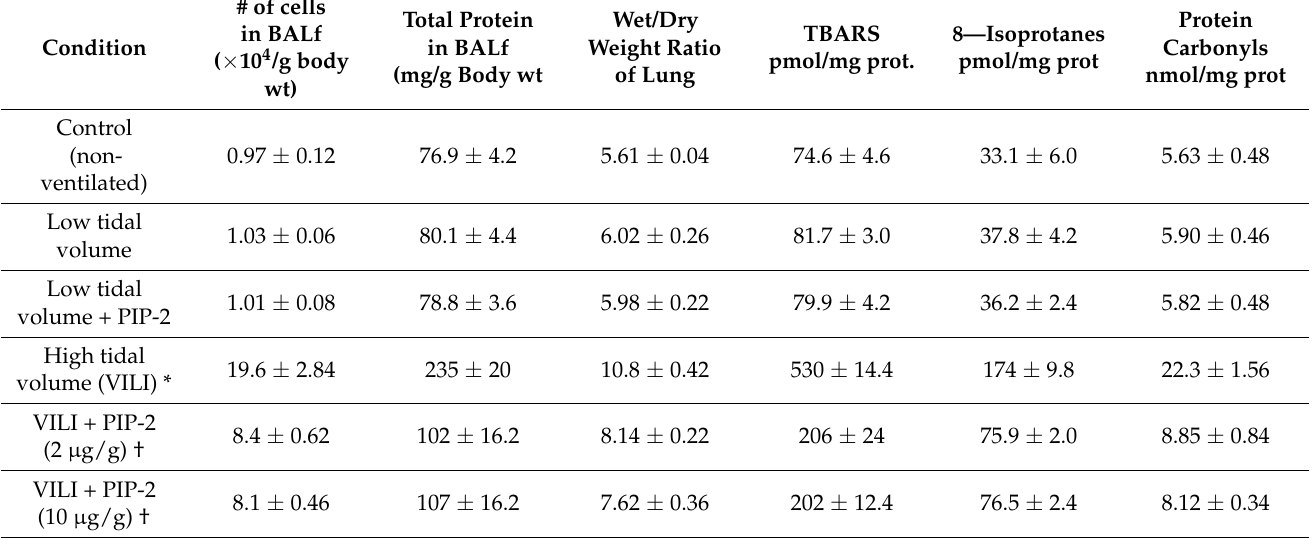
Table 3. Effect of intratracheal (IT) PIP-2 on manifestations of VILI. Male mice were ventilated for 6hr with tidal volume of 4 (low) or 12 (high, VILI) mL/Kg, respiratory rate 120/min, PEEP 2 cm H 2 O. Mice were administered PIP-2 (2 or 10 µ g/g body weight) encapsulated in liposomes by IT bolus infusion. After 6 h, mice were sacrificed, and lungs processed as described in Materials and Methods. Results are mean ± SD for n = 4. * p < 0.05 vs. all other groups. † p < 0.05 vs. Control, Low tidal volume ( ± PIP-2) and VILI. There are no significant differences between 2 and 10 ug/g PIP-2.